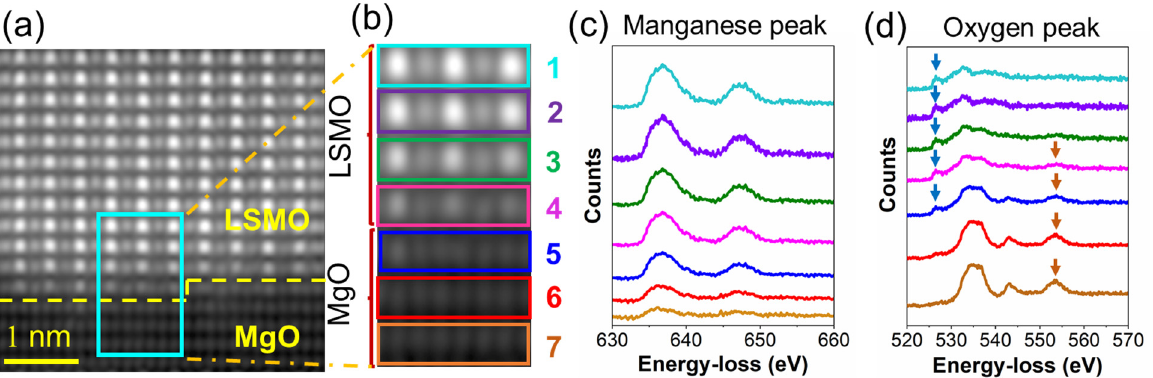
Figure 4. ( a , b ) Atomic-resolution HAADF image of LSMO grown on MgO, ( c , d ) atomic plane-by-plane EELS spectra for Mn and O-K edge within the LSMO and MgO corresponding to planes shown in ( b ).